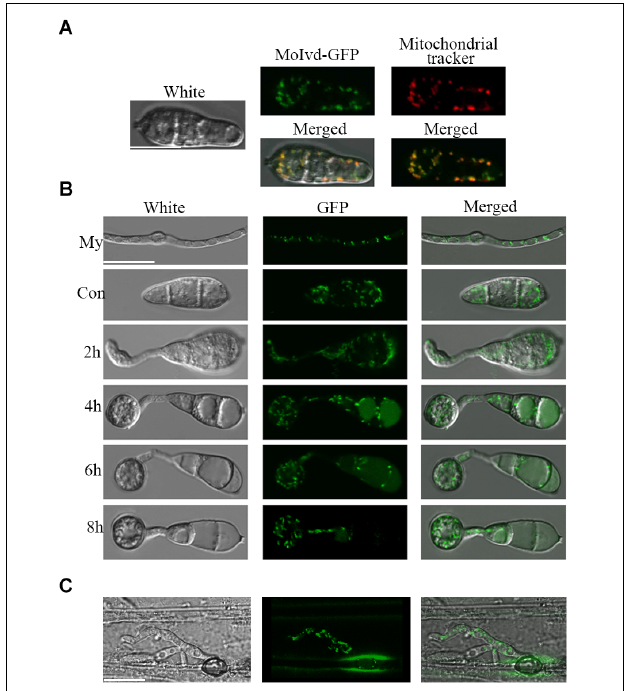
FIGURE 7 | Subcellular localization of MoIvd-GFP. (A) MoIvd-GFP co-localizes with the mitochondrial tracker showing red light analyzed by laser scanning confocal microscopy. The tracker was purchased by Invitrogen with catalog number M7152. Image was taken after the conidia were treated with tracker for 3 min. Bar = 10 µ m. (B) MoIvd-GFP stably expressed during mycelia (My) growth, conidia (Con) and appressorium development. Bar = 10 µ m. (C) MoIvd-GFP expressed in invasive hyphae by barley infection assay. Bar = 10 µ m.